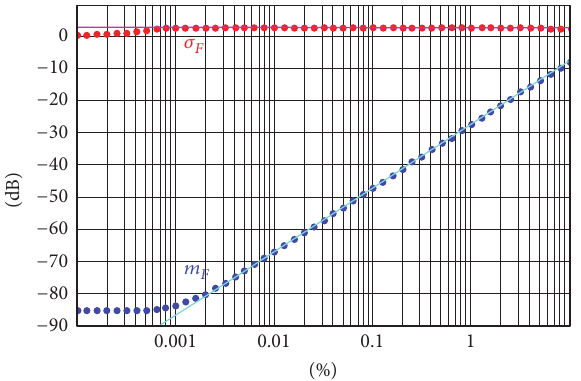
Figure 23: 𝑚 𝐹 and 𝜎 𝐹 versus 𝜎 𝐶 and linear regression lines based on the values obtained for 0.01 % ≤ 𝜎 𝐶 ≤ 10